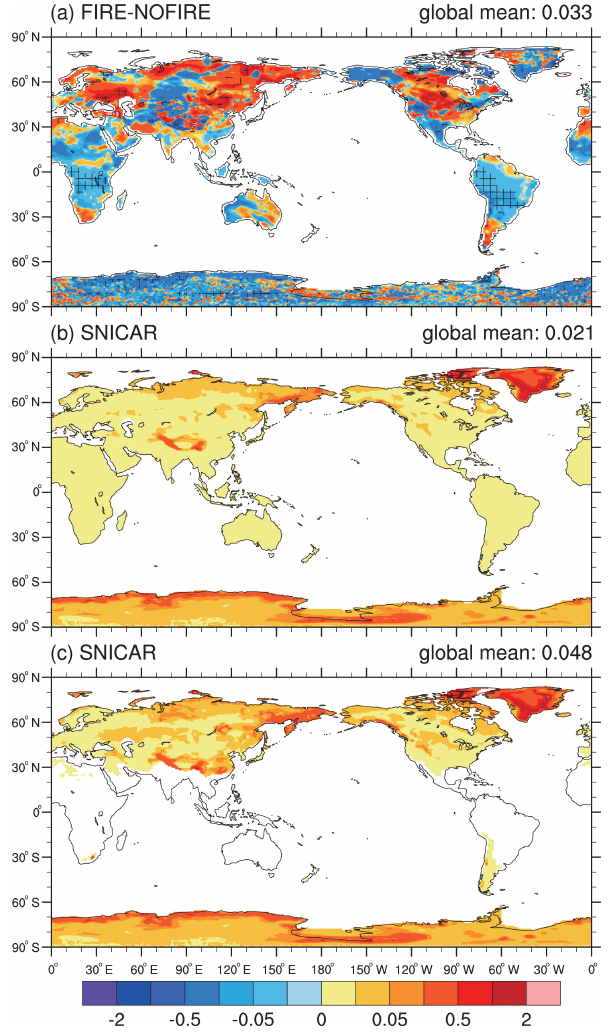
Figure 10. (a) Annual mean radiative effect due to surface-albedo changes (REsac, Wm − 2 ) averaged over the period of 2003–2011 of all fire aerosols over land regions, and annual mean surface effect of fire BC-in-snow calculated from SNICAR averaged (b) over all times and (c) only when snow is present. The plus signs in (a) de- note the regions where the radiative effect is statistically significant at the 0.1